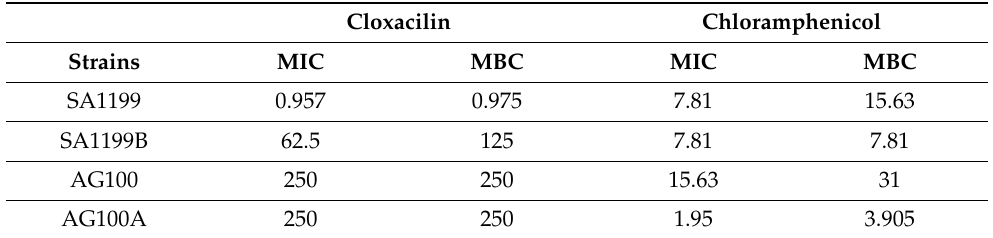
Table 1. Different MIC and MBC (mg/mL) of the antibiotics used against E. coli and S. aureus